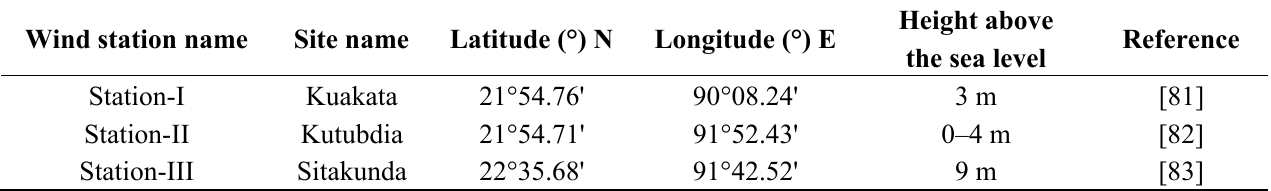
Table 1. Site name, location for wind speed measuring at 20 m and 30 m height above